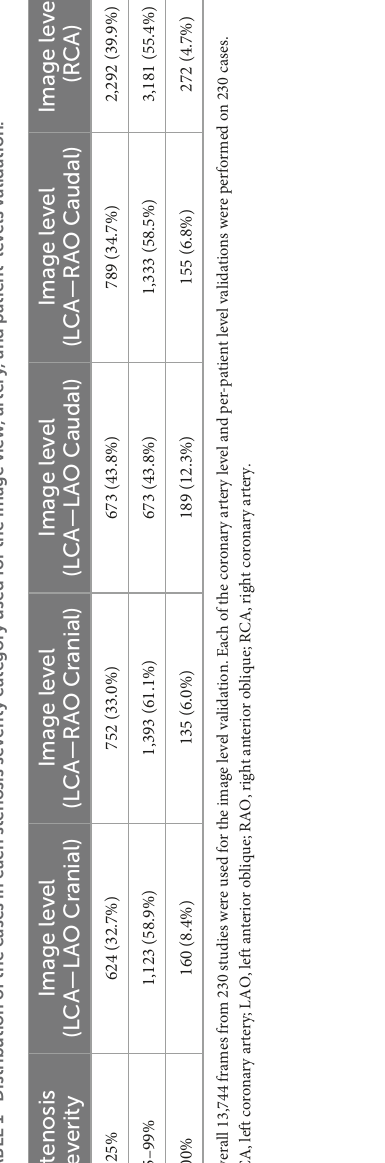
anchor-based FPN model is developed from RetinaNet (34) and FPNs (35), using the pre-trained inception-V3 as backbone. The network structure is demonstrated as Supplementary Figure 2 . The 1st, 2nd, and 3rd feature map in the pyramid were derived from the output of the concatenate feature before the 1st, 2nd, and 3rd pooling layer, respectively. The 4th and 5th feature maps were down sampled from the previous layers. For FPN inputs, 1,588 positioning boxes with a minimal size of 35 × 35 pixels were annotated by two independent expert cardiologists. The shapes of anchor were preset by K-Means clustering method with seven different groups of height and width. The anchor-based model was trained with Learning Rate = 1e − 4 over 500 epochs. Then FPN was built on the feature maps of pre- trained classification models. The same reader-annotated bounding boxes were also used for the evaluation of the CAM-based localization